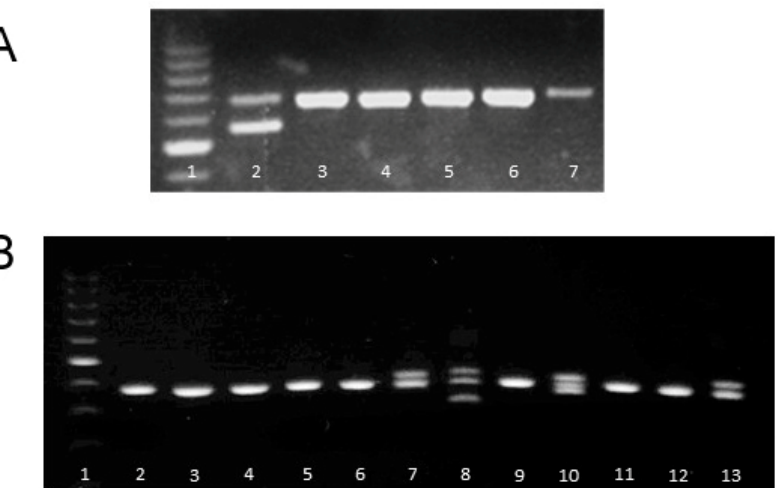
Figure 1. Panel ( A ). Heterozygous TCR-V β 13 knockout founder among the first six LEW.1WR1 littermates (lane 2). The first lane is marker DNA; lanes 3–7 are wild-type. Panel ( B ). Heterozygous Ubash3a knockout founders among first derived progeny (lanes 7, 8, 10, and 13). Lane 1 is marker DNA; lanes 2–6, 9, 11–12 are samples from wild-type, non-deleted siblings. The founder used in this study is represented in lane 8 (Founder